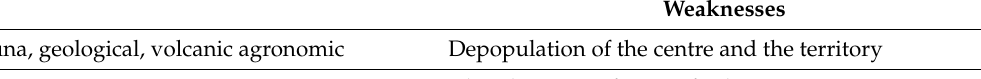
Table 9. SWOT analysis of the Roccamonfina and Foce Garigliano Regional Natural Park, Region Campania, Italy.